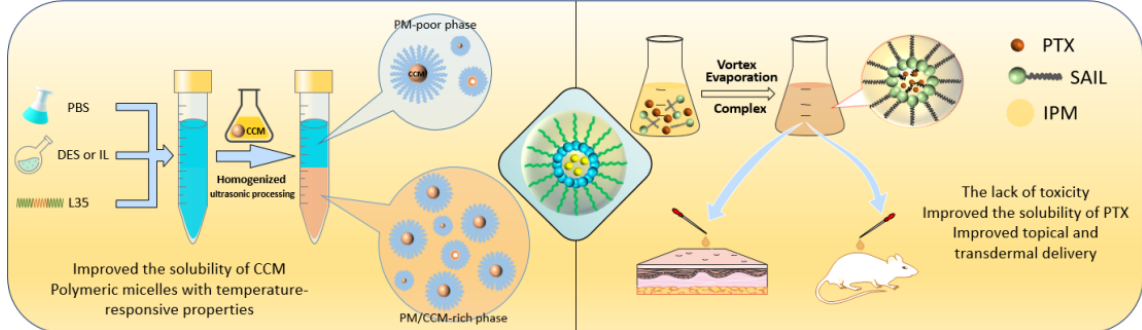
Figure 5. Applications of DES-micelles.